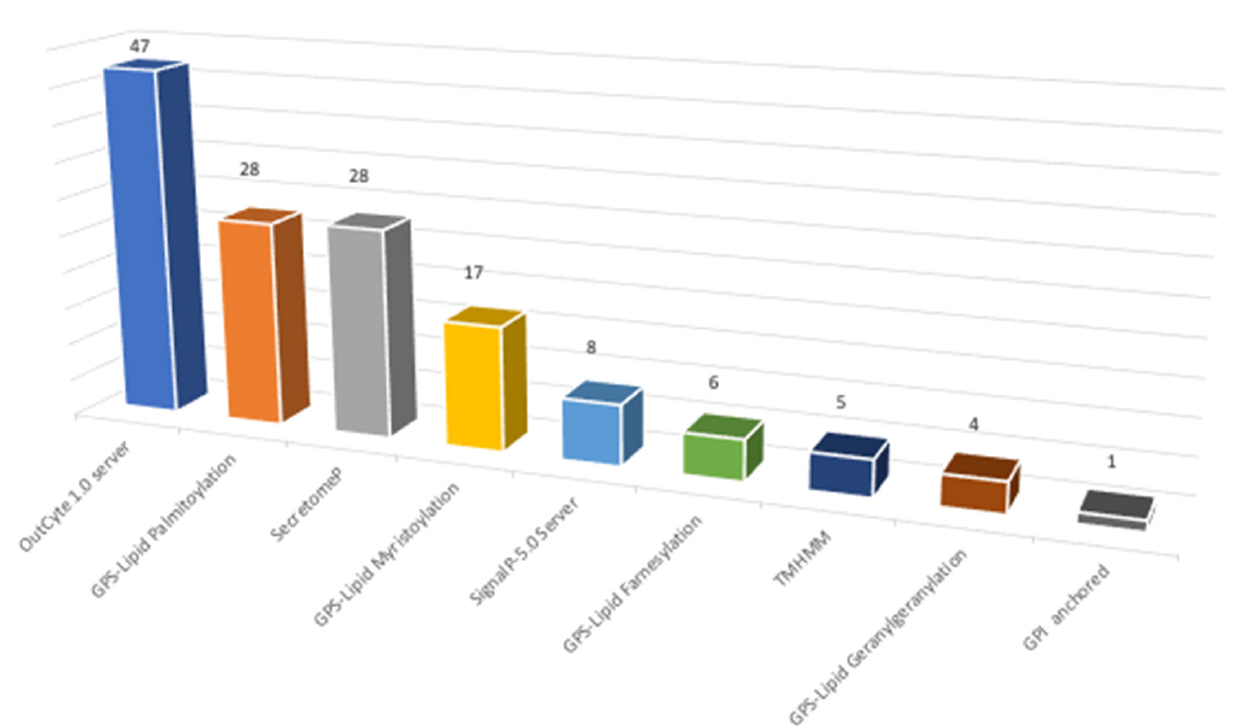
Figure 5. Characterization of surfactome proteins according to their type of association with membrane (data in percentage).